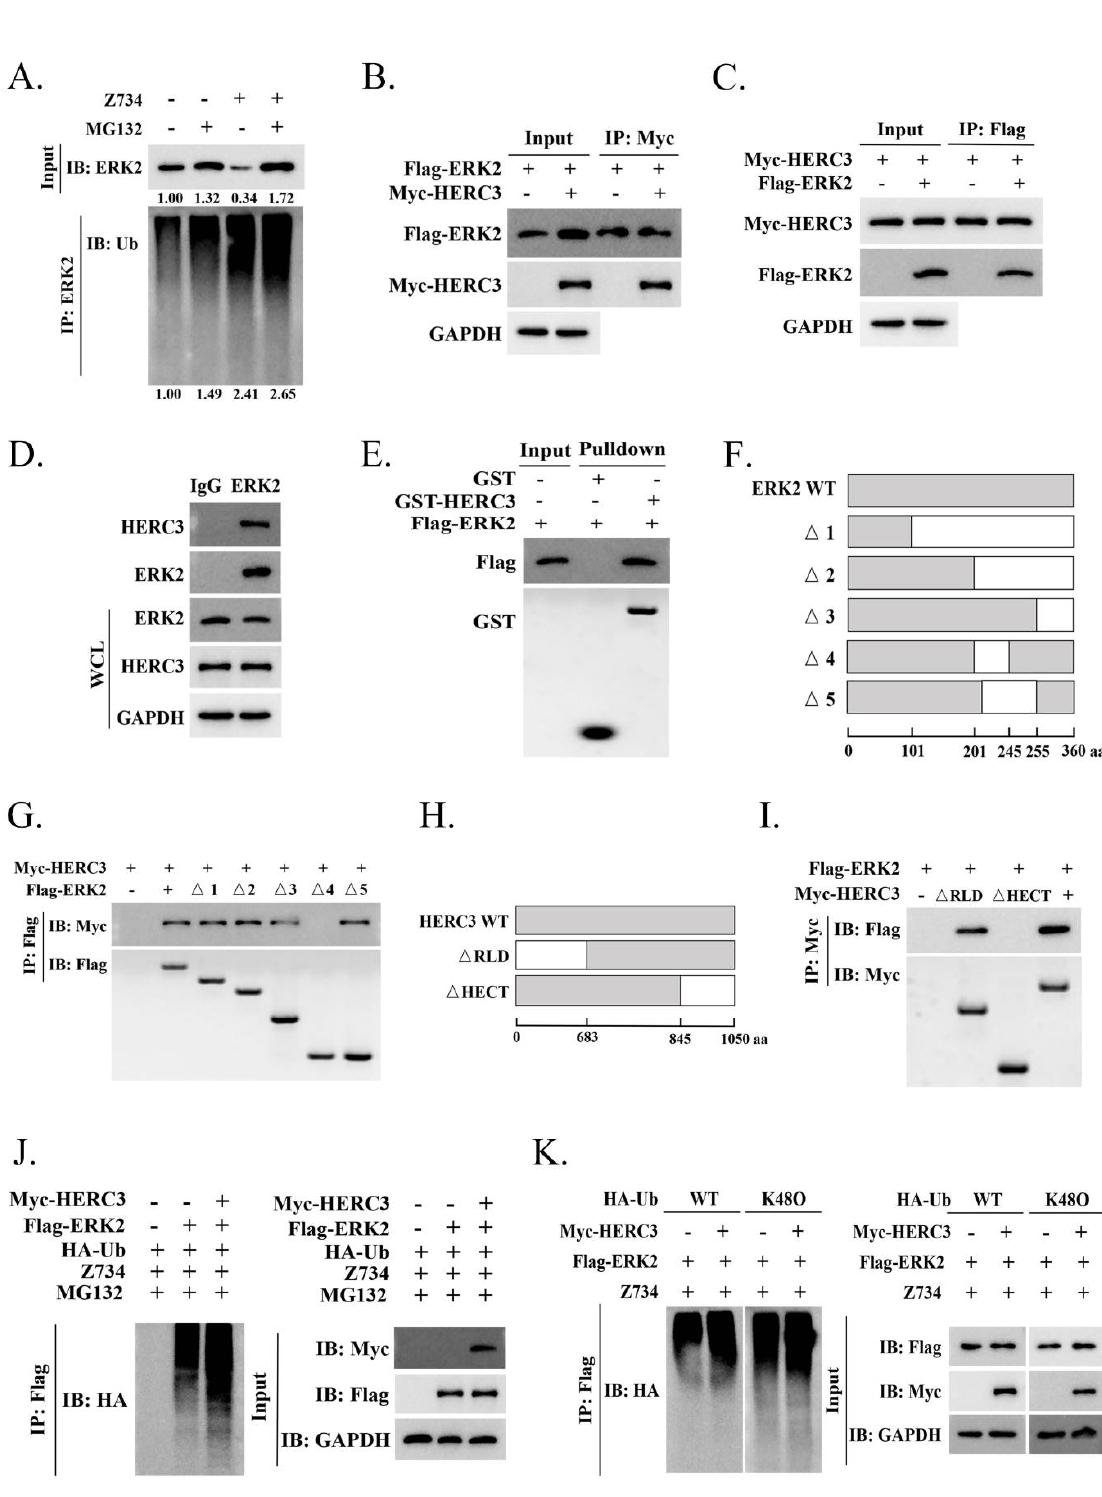
Figure 4. HERC3 interacts with ERK2 and promotes in the Z734–mediated ubiquitination of ERK2. ( A ) MCF–7 cells were treated with MG132 (10 mM) and Z734 (10 μM) for 12 h. ( B ) Total lysates from MCF–7 cells expressing Myc–HERC3 in the presence of Flag–ERK2 were subjected to immunoprecipitation (IP) with anti–Myc followed by Western blotting using the indicated antibodies. ( C ) Total lysates from MCF–7 cells expressing Flag–ERK2 in the presence of Myc–HERC3 were subjected to IP with anti–Flag followed by Western blotting using the indicated antibodies. ( D ) The interaction between endogenous ERK2 and HERC3 was analyzed via co–immunoprecipitation. IP samples and